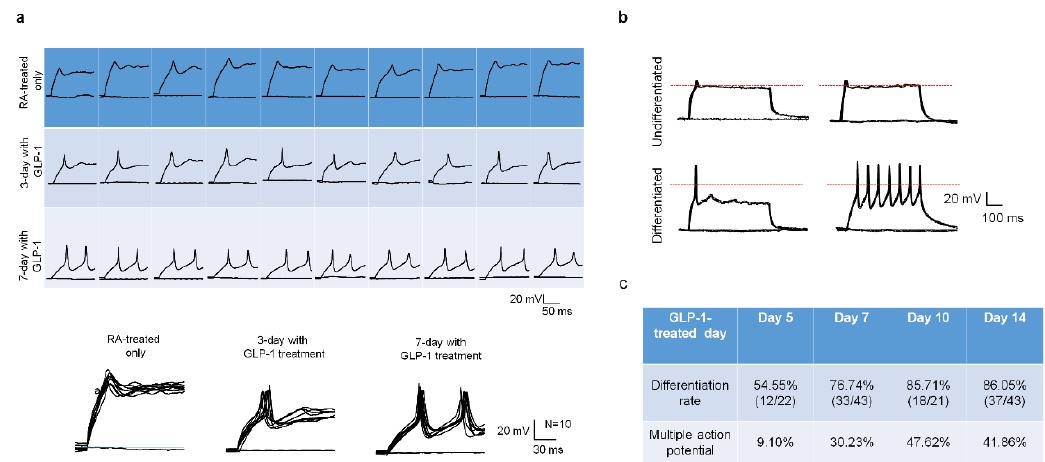
Figure 5. GLP-1 di ff erentiated SH-SY5Y neurons have neuronal action potentials in response to electrical stimulation. The single cell patch clamp technique was employed to determine the electrophysiological function of GLP-1 di ff erentiated SH-SY5Y neurons. The retinoic acid (RA, non-GLP-1) treated (undi ff erentiated) cells showed no response to stimulation, and 3-day GLP-1 treated SH-SY5Y cells (intermediate di ff erentiated) started showing responses until 7-day GLP-1 treated (di ff erentiated) SH-SY5Y cells had immediate action potential responses to stimuli ( a ). The neuronal action potential was also used to determine the maturity of GLP-1 di ff erentiated neurons. The di ff erentiated mature (7-day GLP-1) neurons showed responses to single and multiple stimuli, but undi ff erentiated (5-day RA) cells did not ( b ). The longer GLP-1 treatment resulted in higher percentage of mature neurons ( c ). These results suggested that GLP-1 administration was able to induce physiologically functional neurons. (the red dotted line shows V = 0).